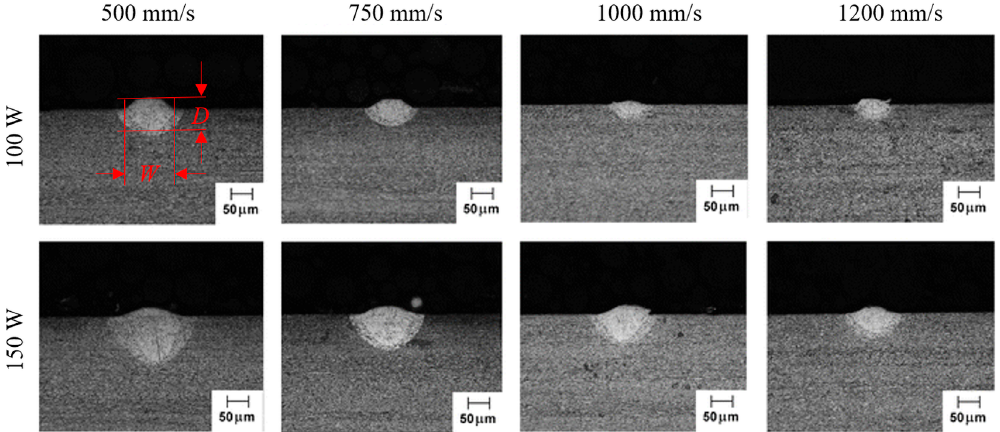
Figure 6. Calculation of molten pool dimensions from a three-dimensional temperature profile. L , W , and D represent the molten pool length, molten pool width, and molten pool depth, respectively.